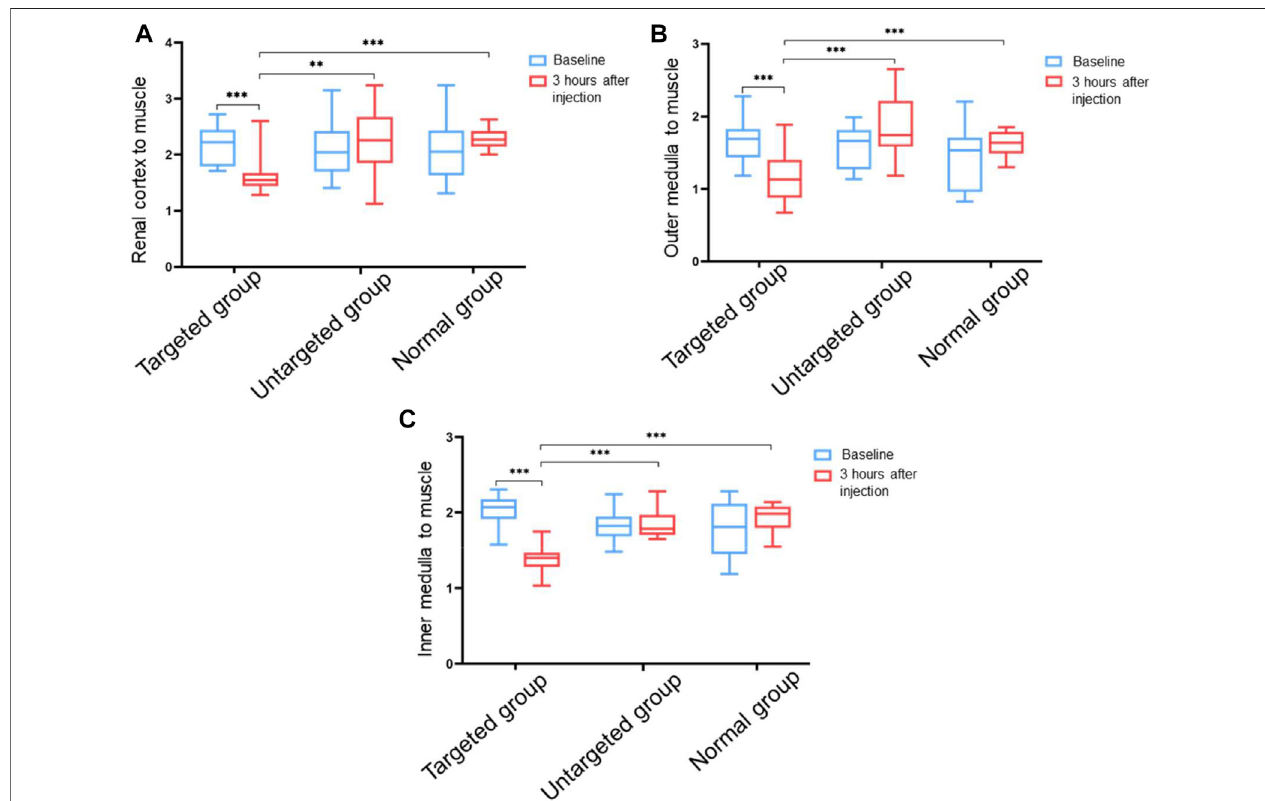
FIGURE 6 | Ratio value of T2WI signals in different tissues of rat kidney to muscle tissue before and after injection of Fe 3 O 4 -RGD for 3 h. (A) Ratio value of signal intensity from renal cortex to muscle tissue. (B) Ratio value of signal intensity from the outer medulla of the kidney to the muscle tissue. (C) Ratio value of signal intensity from the inner medulla of the kidney to the muscle tissue (** p < 0.01, *** p <